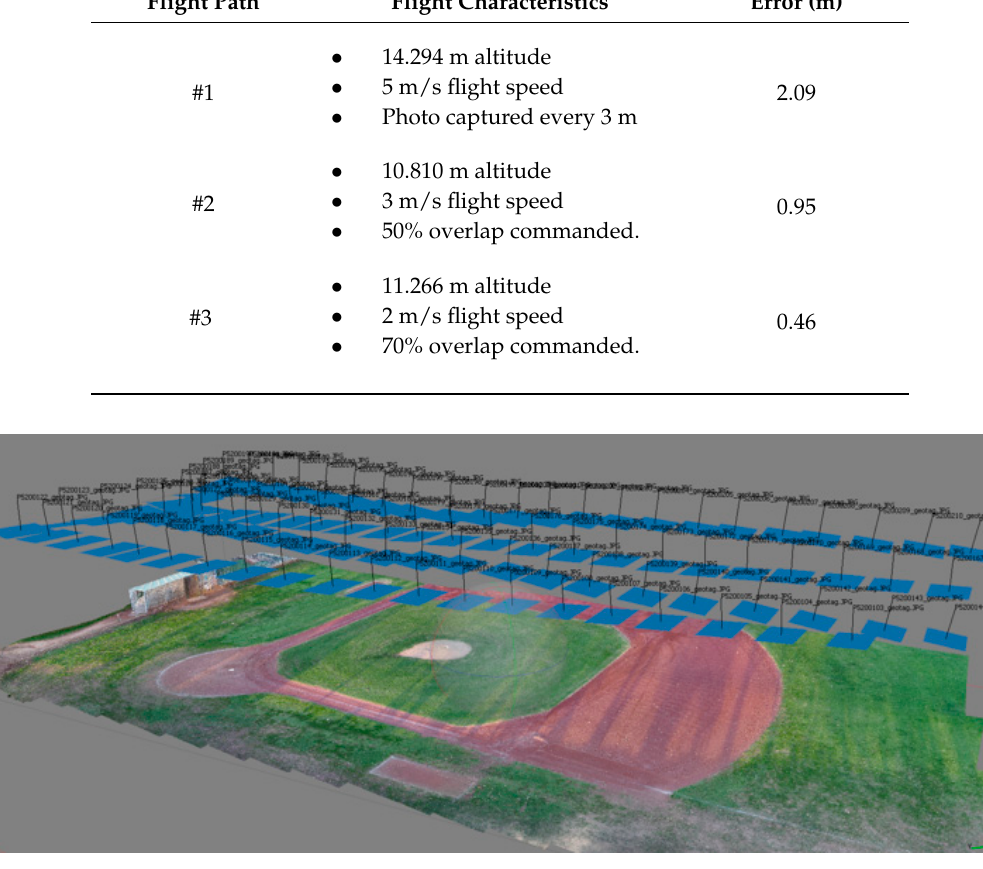
Figure 4. Photo locations taken by the UAV over the baseball pitch